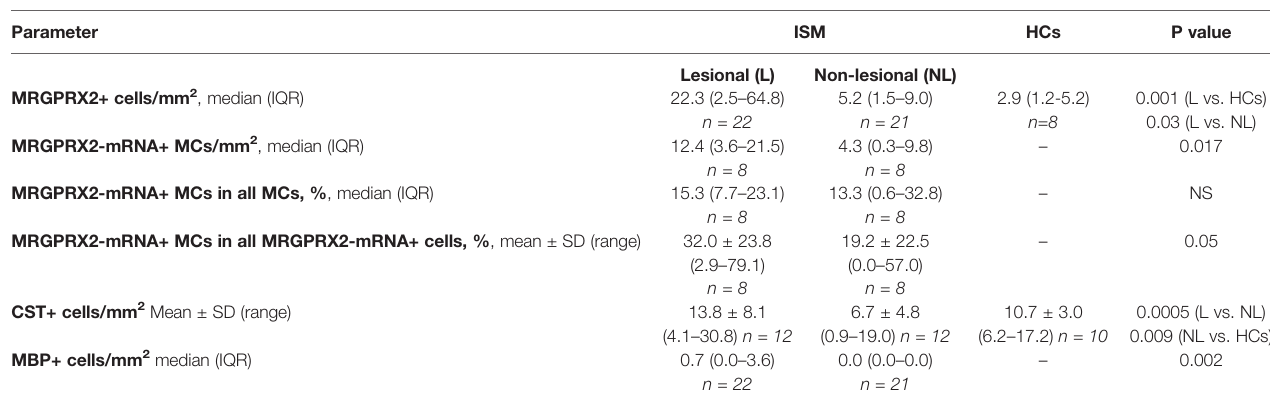
TABLE 2 | MRGPRX2 and its agonists in the skin of ISM patients and healthy controls. Parameter